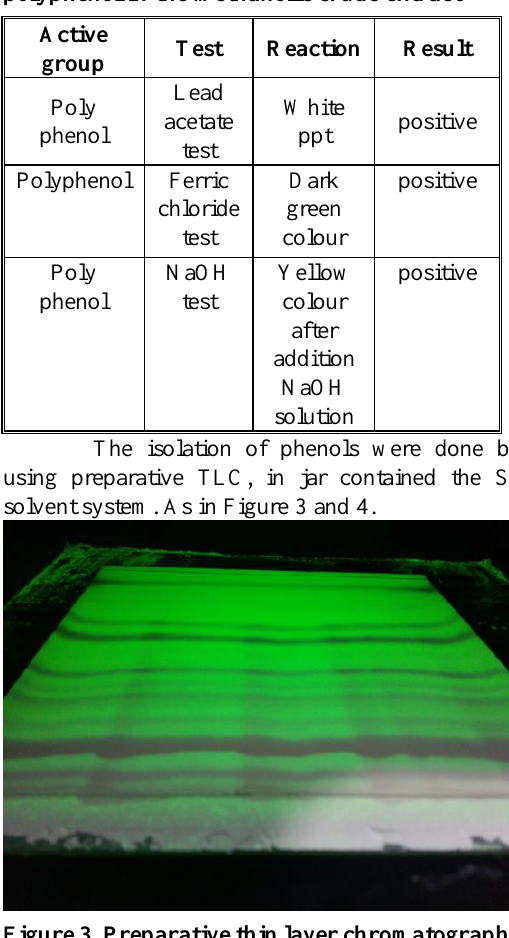
Table 2. Results of the phytochemical analysis of polyphenol in the methanolic crude extract